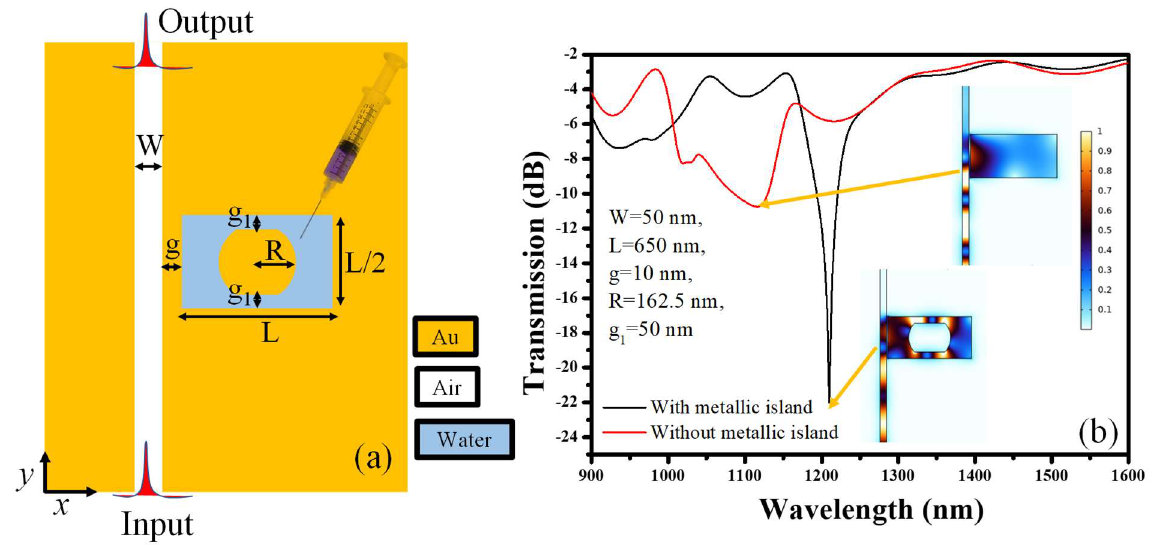
Figure 1. ( a ) Schematic representation of a MIM waveguide-based plasmonic sensor; ( b ) Transmission spectra of the sensor with a metallic island and without a metallic island.